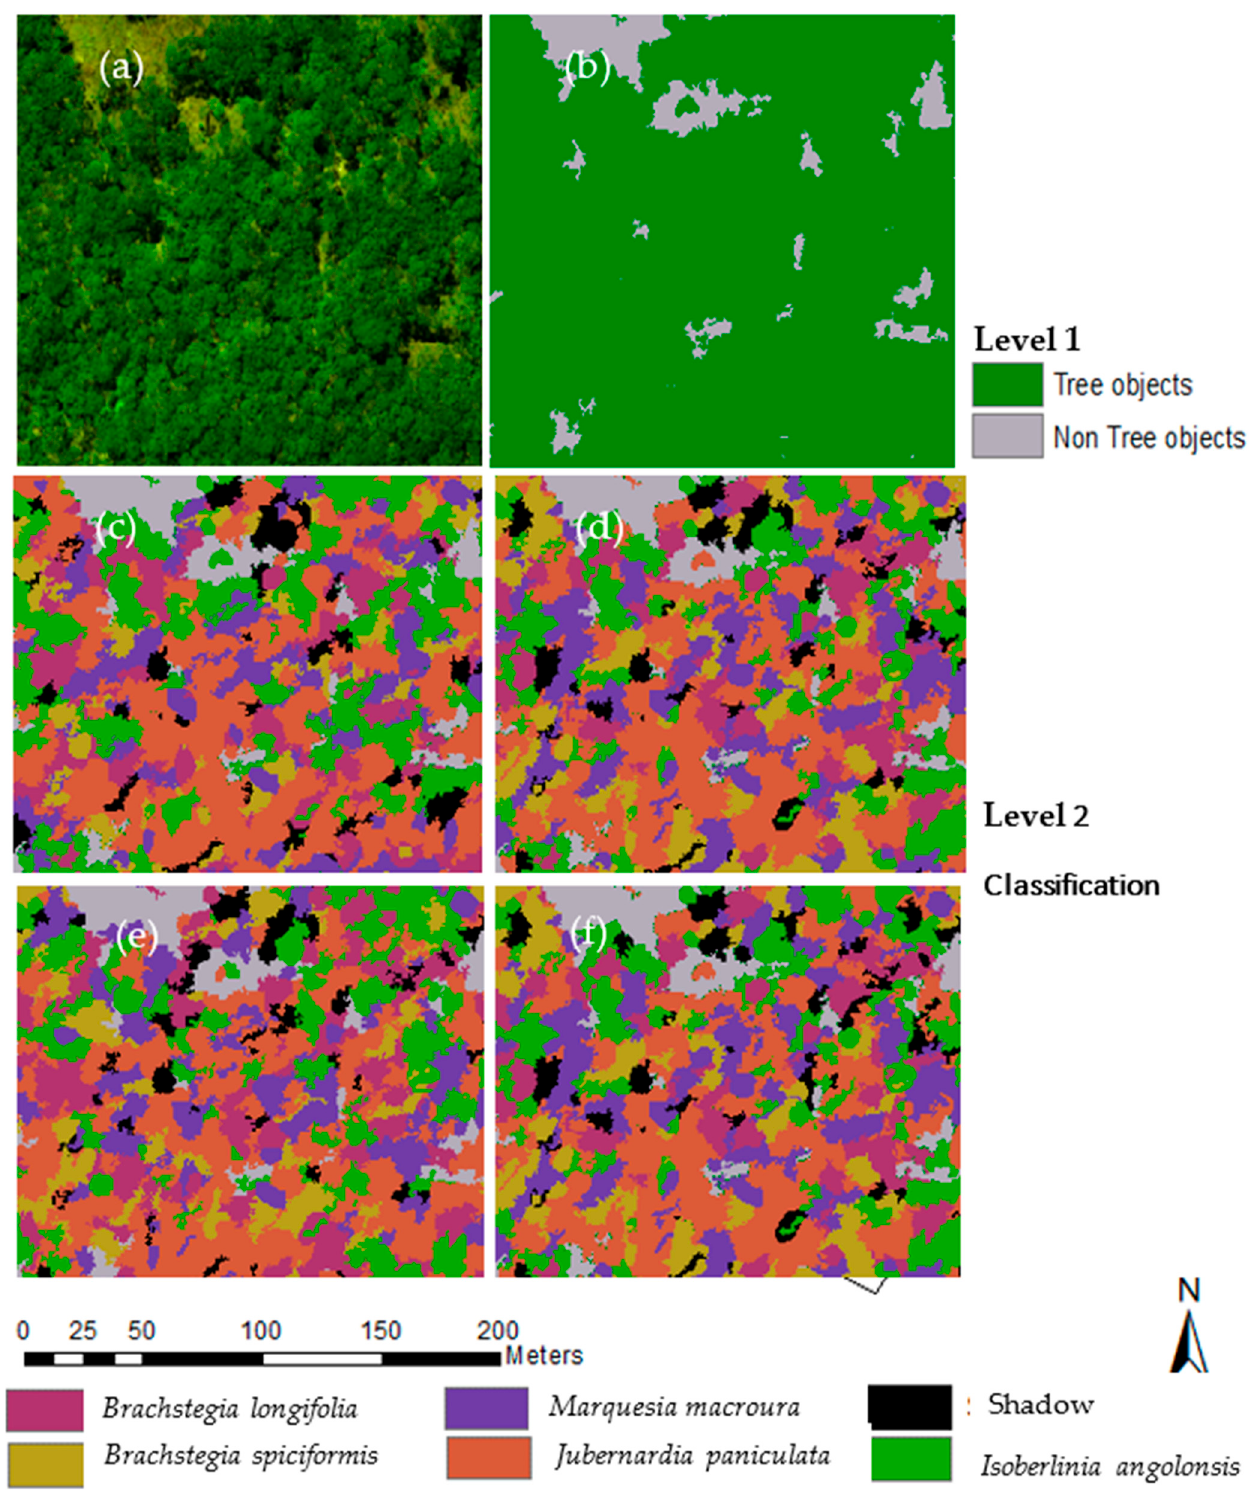
Figure 8. Classification of dominant tree species: ( a ) orthophoto mosaic at leaf maturity; ( b ) level 1 classification to separate trees from non-tree objects; ( c ) species classification at leaf maturity (May image); ( d ) species classification at transition to senescence (August image); ( e ) species classification at flushing of new leaves; and ( f ) species classification using multi-date and multi-feature image combination.